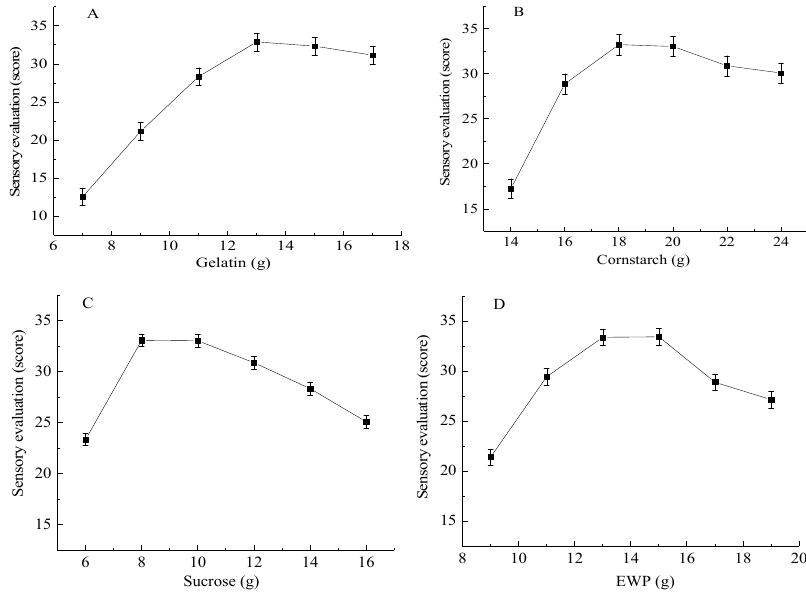
Figure 2. E ff ects of di ff erent amounts of added ( A ) gelatin, ( B ) cornstarch, ( C ) sucrose, and ( D ) egg white protein (EWP) on the sensory evaluation of 3D printing